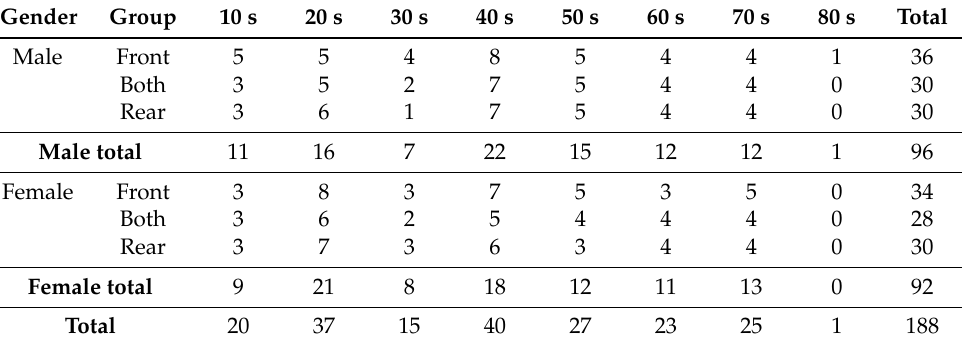
Table 3. Details of